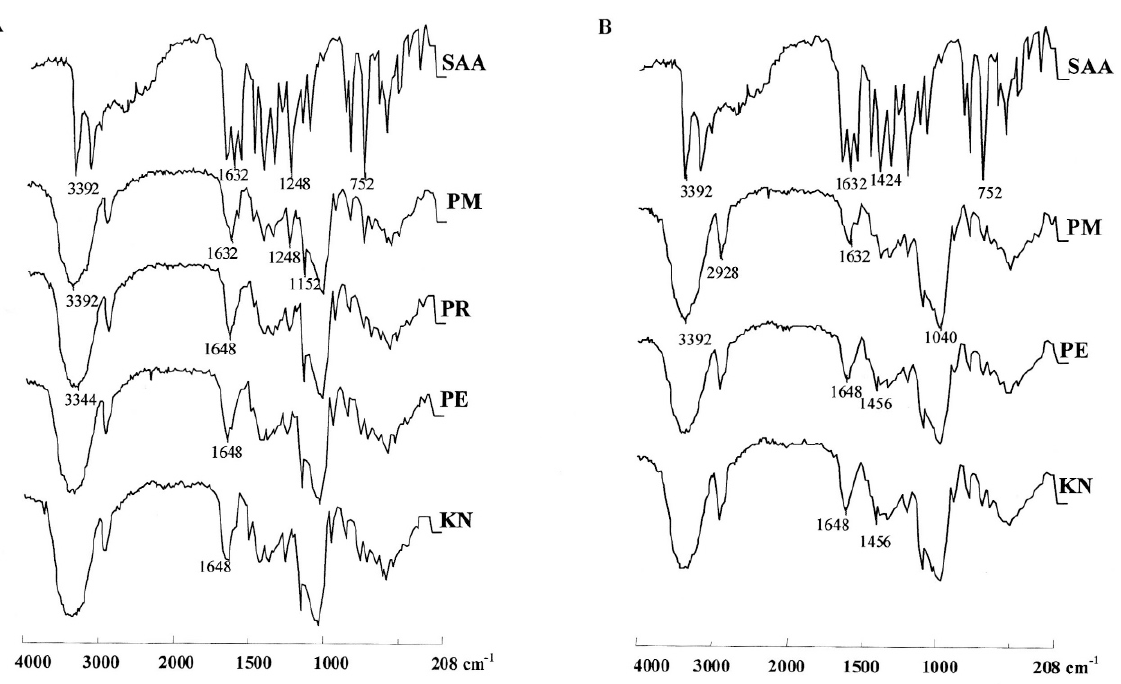
Figure 7. IR spectra of salicylamide (SAA), its physical mixtures (PM) and inclusion complexes (PR, PE, KN) with β -cyclodextrin (A) and 2-hydroxypropyl- β -cyclodextrin